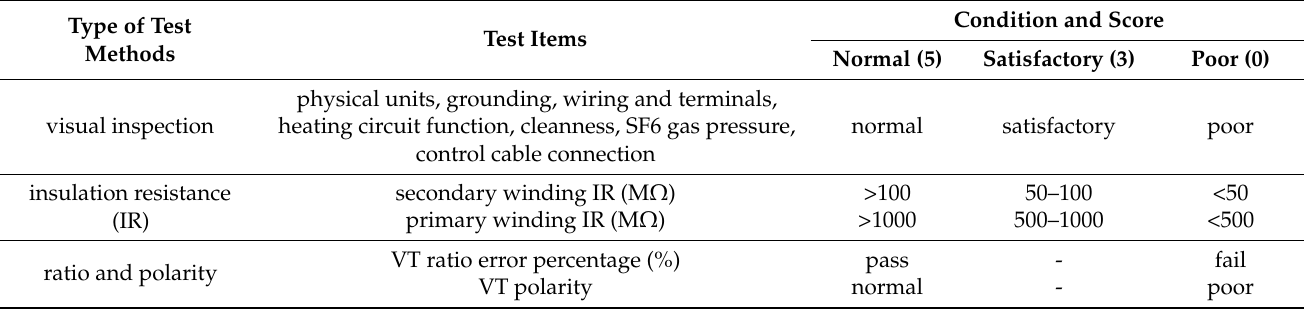
Table 6. VT testing methods and visual inspection.